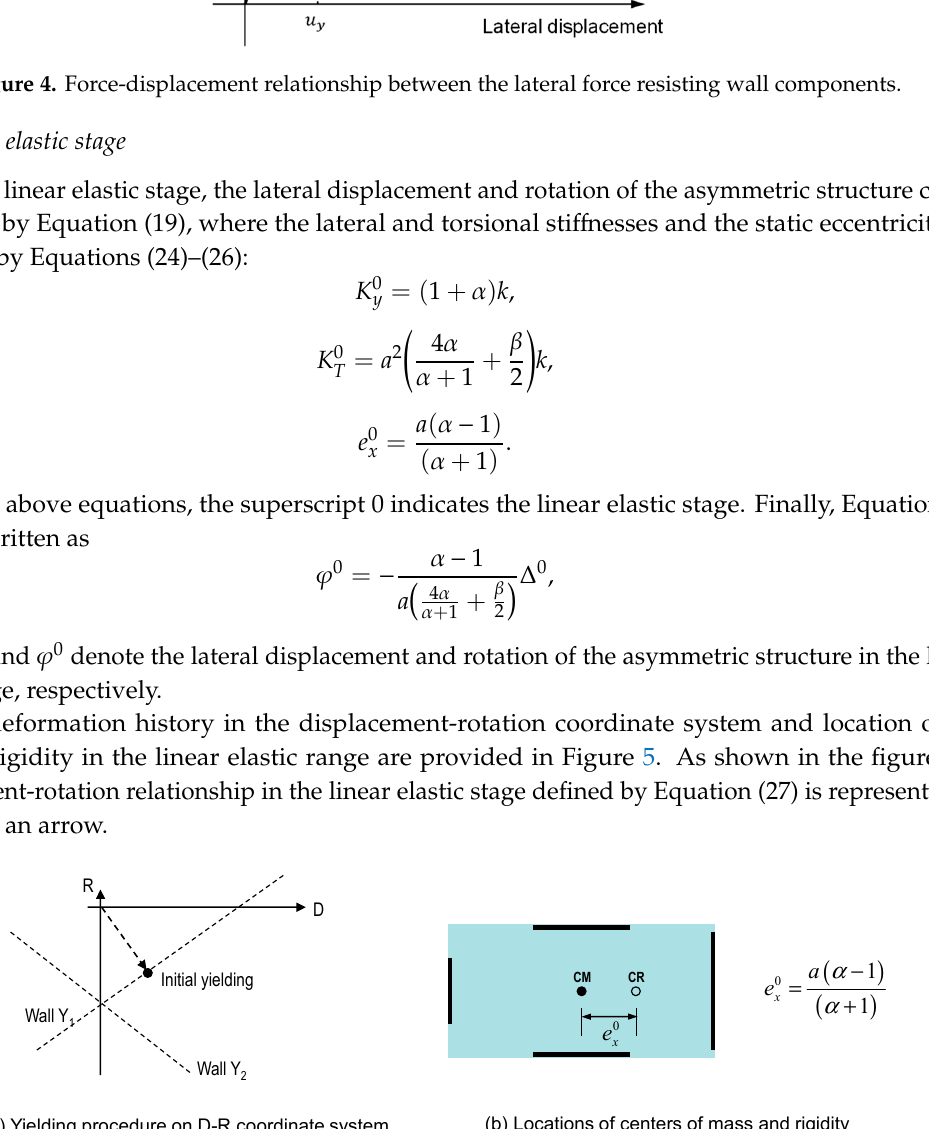
Figure 4. Force-displacement relationship between the lateral force resisting wall components.